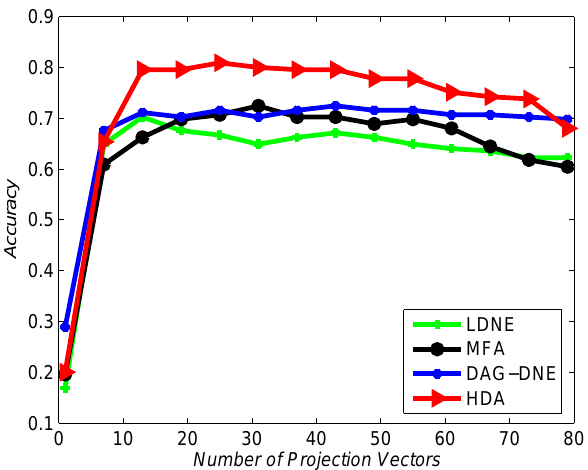
Figure 6. Accuracy vs. Number of Projection Vectors on the Yale dataset under K =